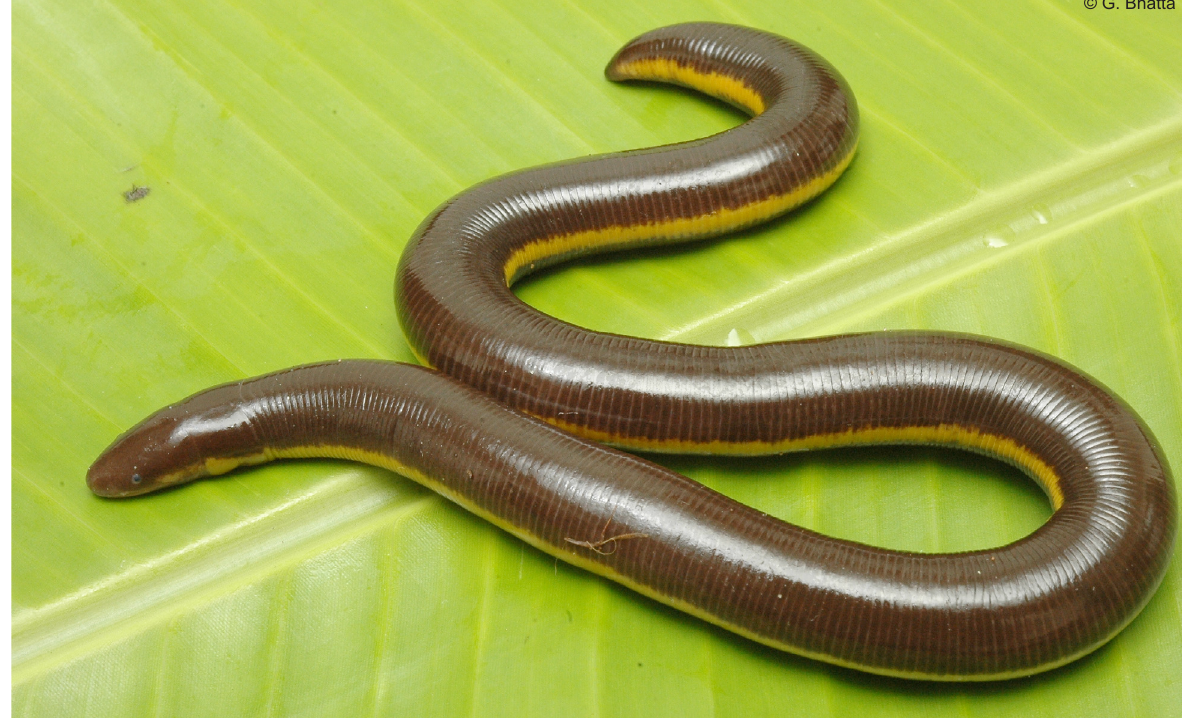
Table 1. Morphometric and meristic details of Ichthyophis kodaguensis from new locality and type locality, Western Ghats.